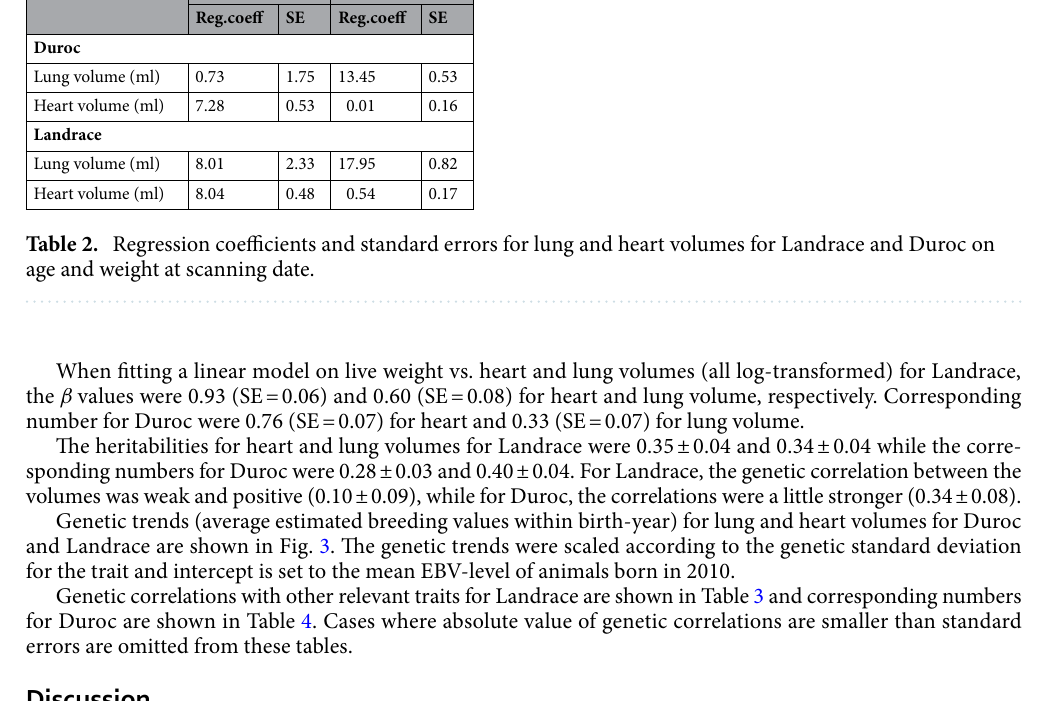
Age at scanning